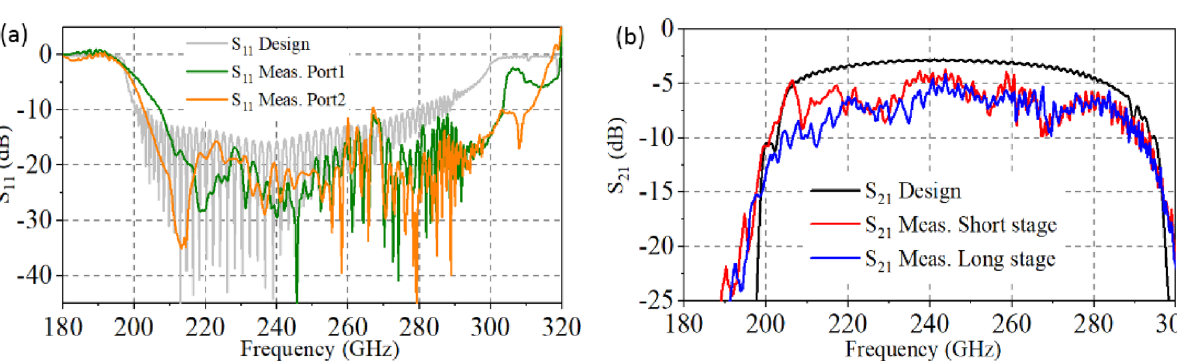
Figure 26. Comparison diagram of the actual test results and simulation of S-parameters. ( a ) S11. ( b )